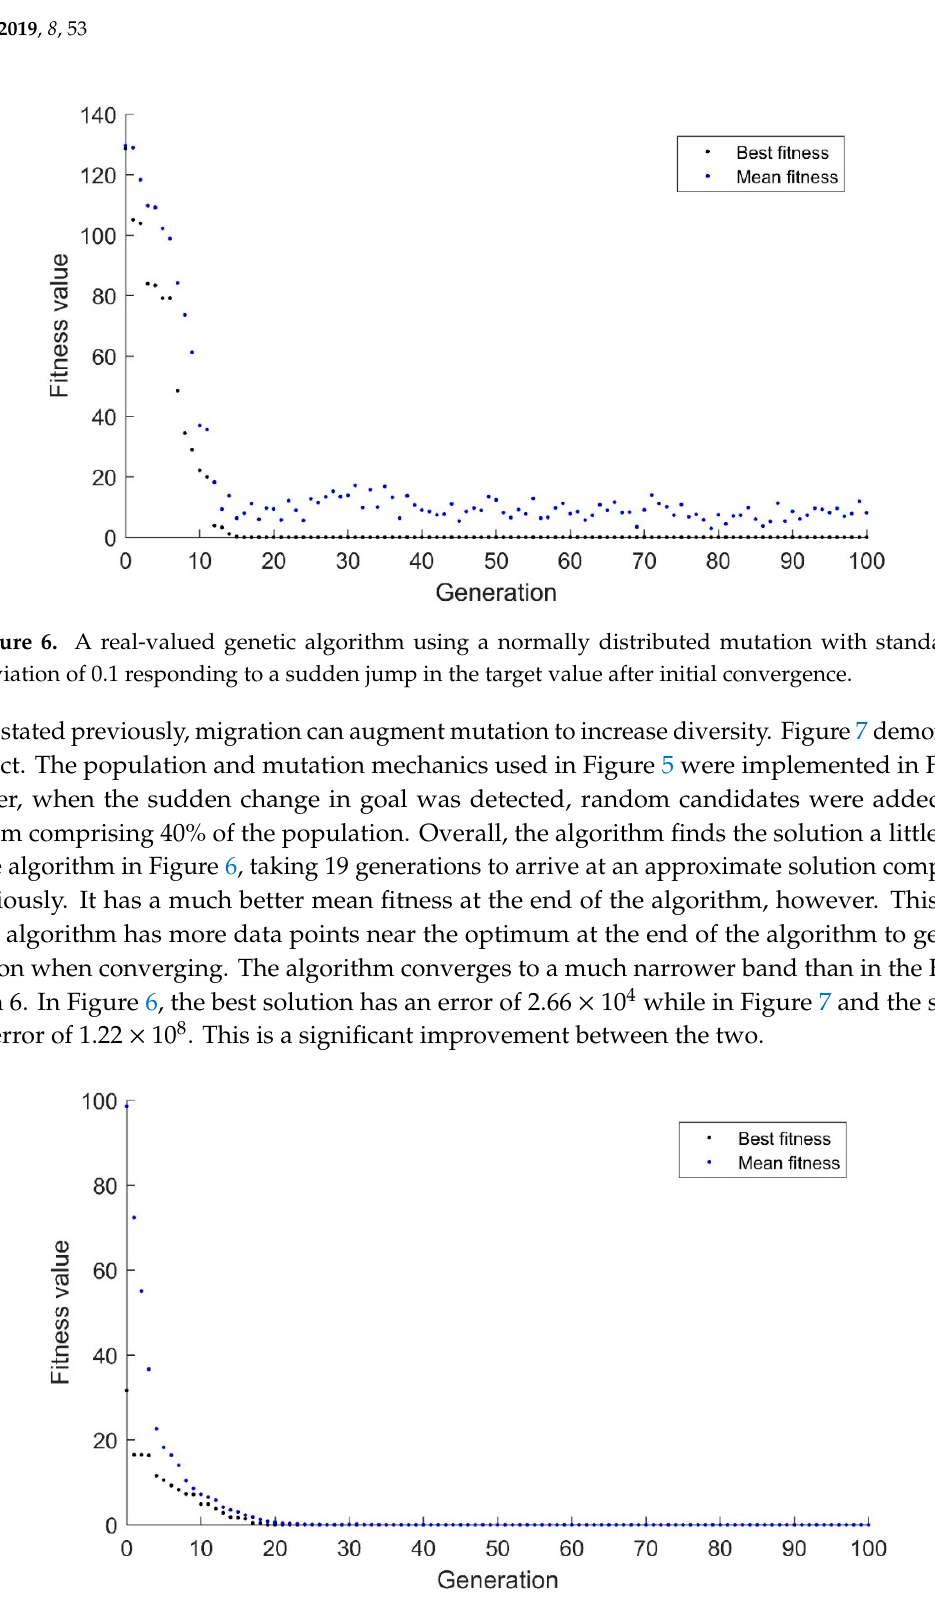
Figure 7. A real-valued genetic algorithm using a normally distributed mutation with standard deviation of 0.01 responding to a sudden jump in the target value after initial convergence when 40% of the population is replaced through migration.